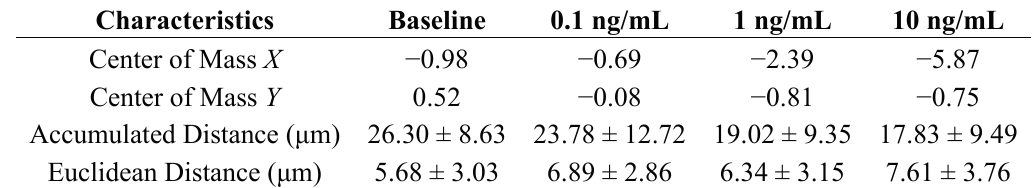
Table 1. Extraneous P. aeruginosa BK-76 cell swimming metrics. Center of